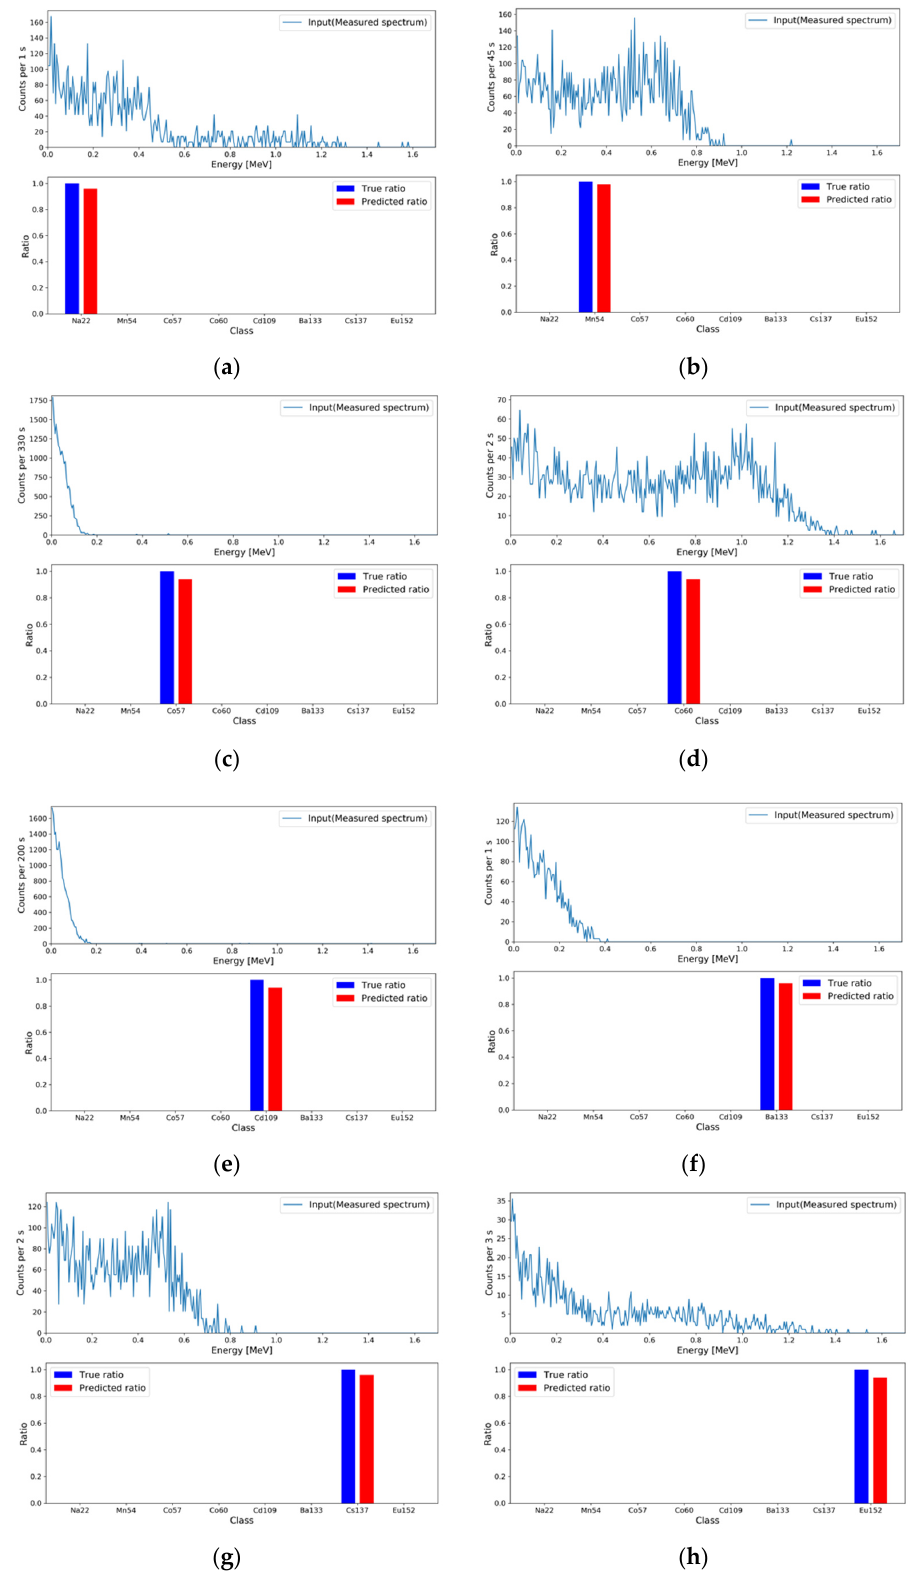
Figure 10. Relative activity regression results for the measured spectra at each MRC. For the eight gamma-ray sources, the MAPEs are ( a ) 5.999 × 10 − 1 ; ( b ) 2.499 × 10 − 1 ; ( c ) 7.499 × 10 − 1 ; ( d ) 7.499 × 10 − 1 ; ( e ) 7.499 × 10 − 1 ; ( f ) 5.001 × 10 − 1 ; ( g ) 5.001 × 10 − 1 ; and ( h ) 7.499 × 10 − 1 .